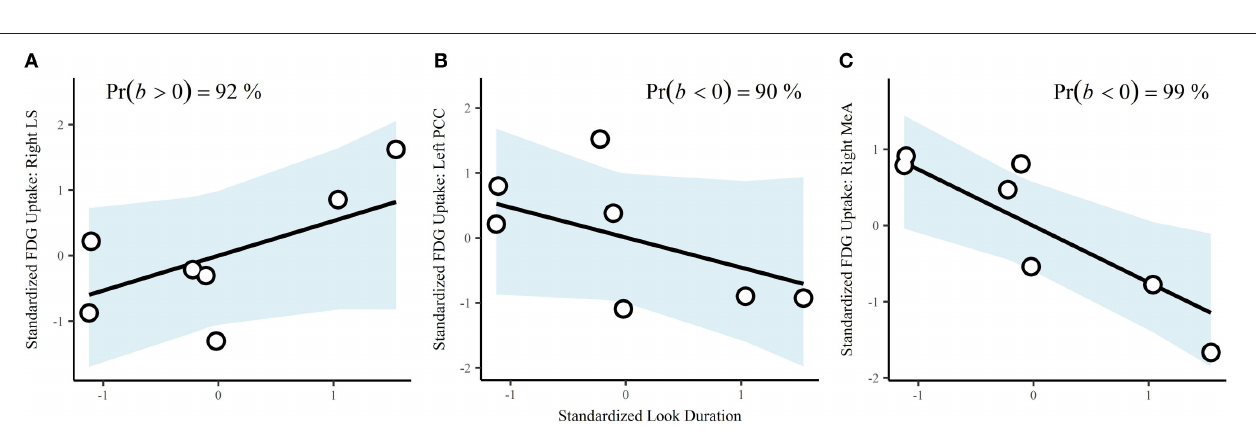
FIGURE 4 | Correlations between look duration and ROIs: (A) , right lateral septum; (B) , left posterior cingulate cortex, and (C) , right medial amygdala. Points are the observed data. The blue shaded areas are the fitted 95% credible regions for the correlations.